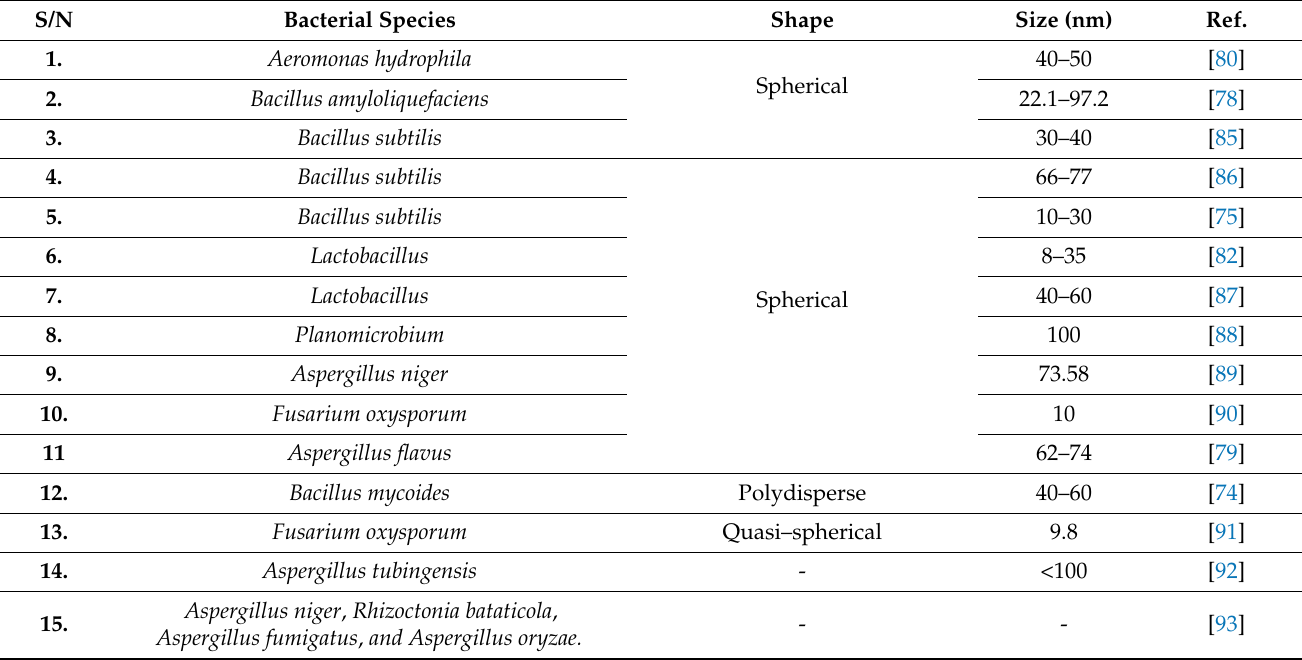
Table 2. TiO 2 NPs produced by several bacterial